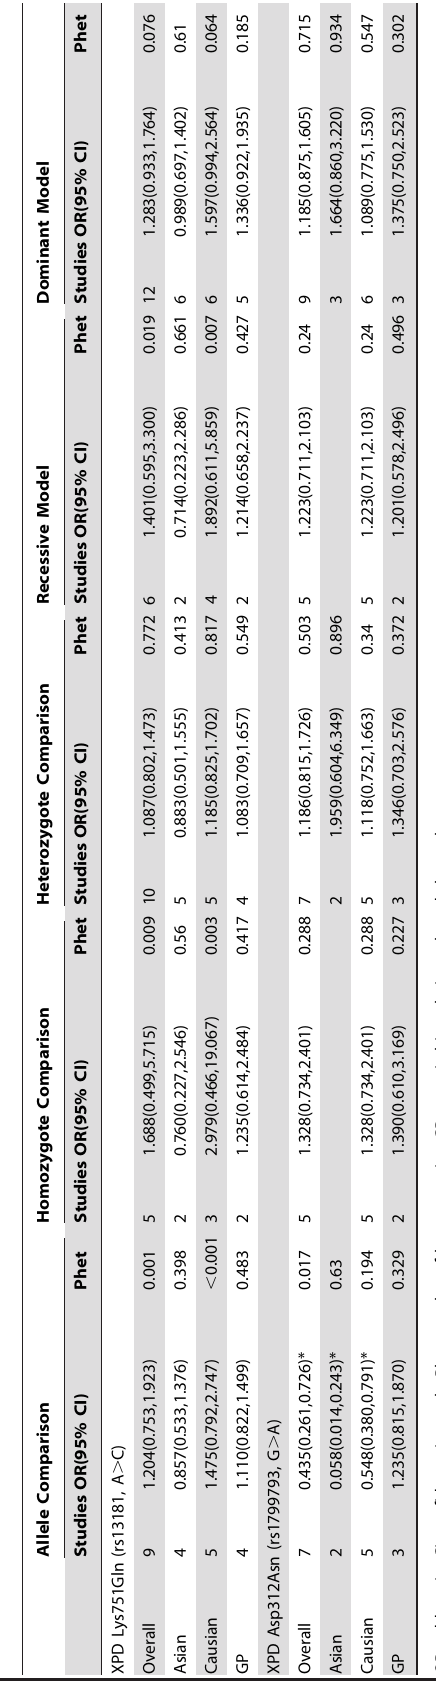
Figure 2) and Caucasian population (Asn vs. Asp, OR =0.548, 95% CI: 0.380–0.791, P heterogeneity = 0.194; Figure 2). No